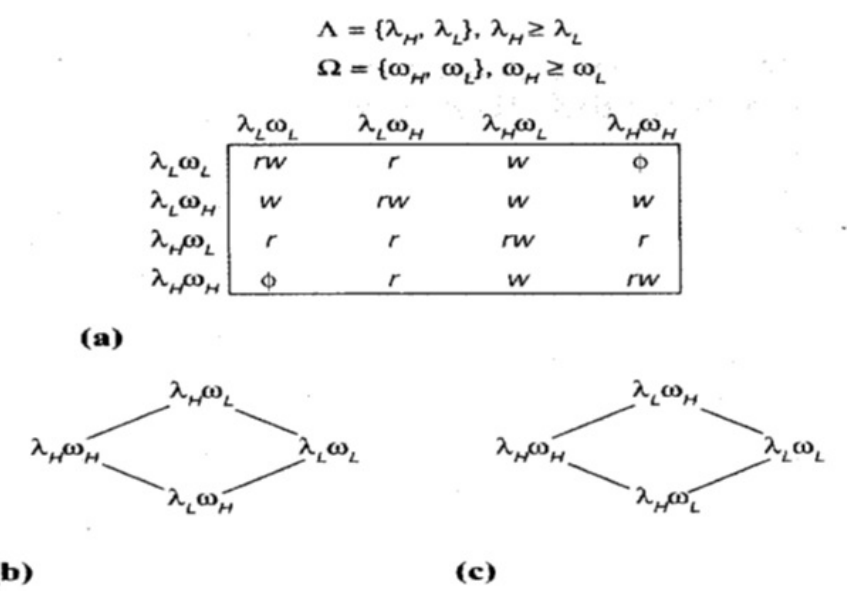
Figure 8. ( a ) Composite model ( b ) Equivalent BLP lattice ( c ) Equivalent Biba